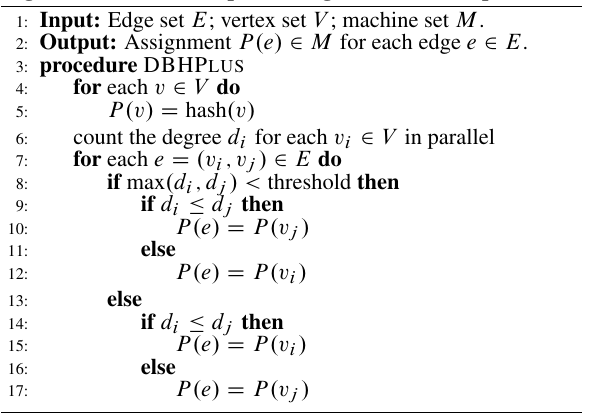
Algorithm 3 DBH+: Improved degree-based hash